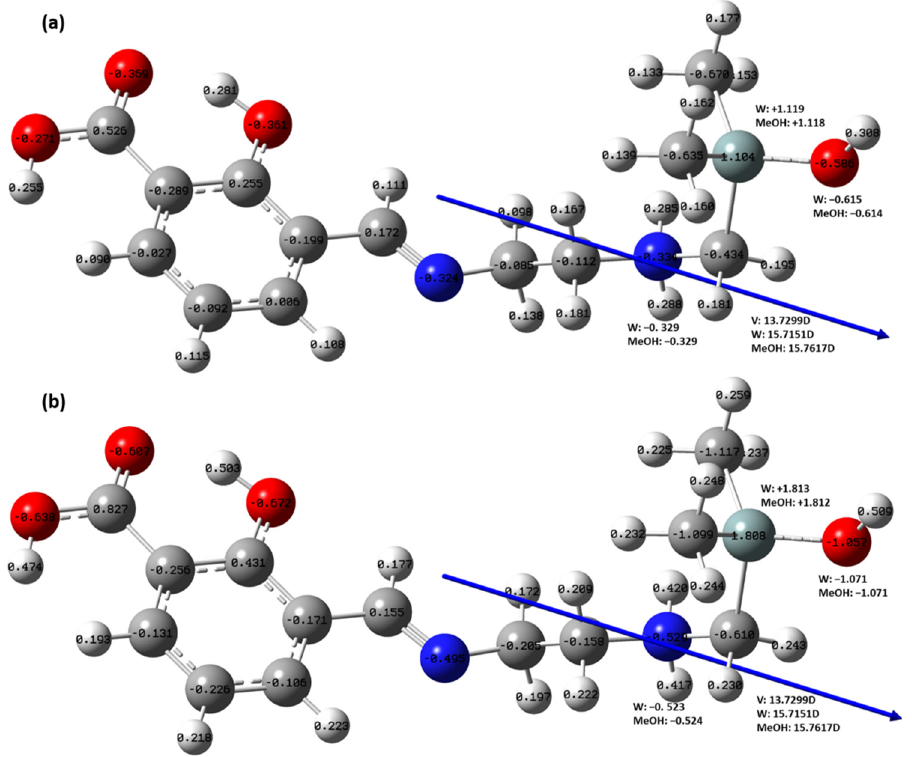
Figure 12. Partial charges for SB-H-silanol ( a ) Mulliken, ( b ) NPA from NBO; implicit solvents: W—water, MeOH—methanol, V—vacuum (c4).